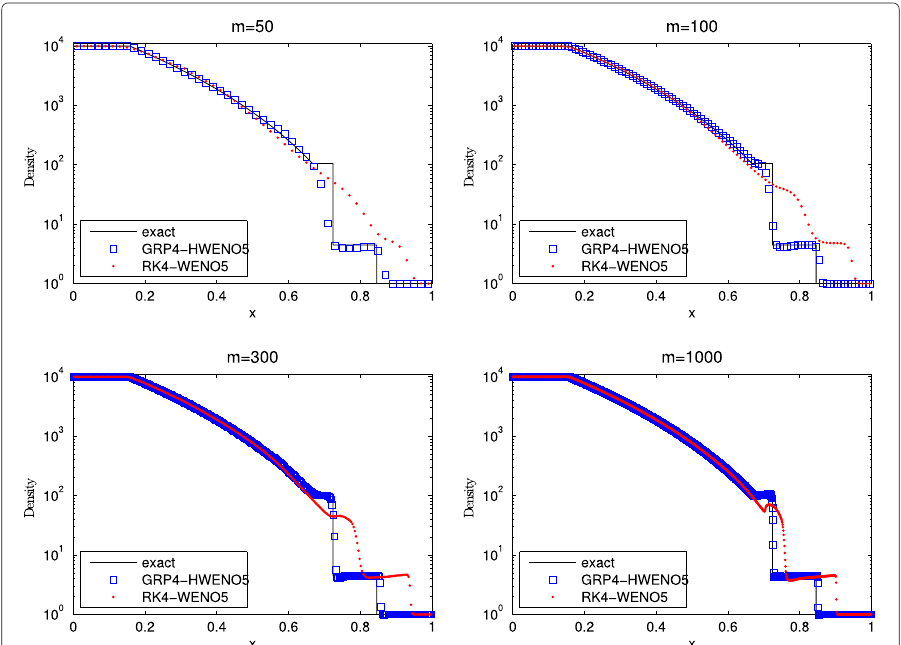
Fig. 7 The comparison of the density profile for the large pressure ratio problem in Example 6. The schemes are GRP4-HWENO5 (squares) and RK4-WENO5 (dots) with m cells.The solid lines are the exact solution